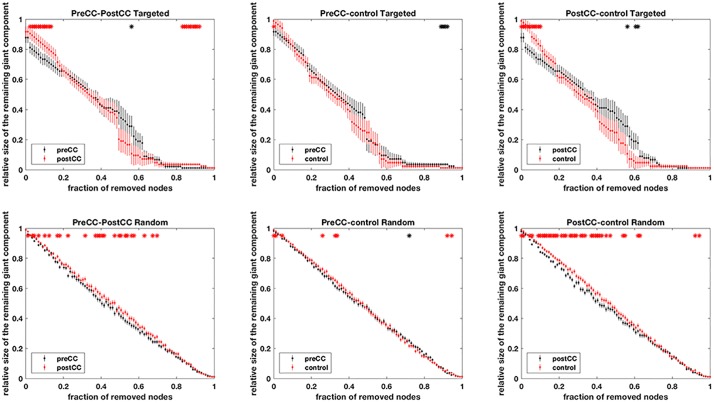
Results of assessments of network resilience to targeted attack or random failure among the three groups.The p-values of AUC comparisons between pre-CC and post-CC networks, between control and pre-CC networks, and between control and post-CC networks are shown in each targeted attack or random failure analysis. The trajectories of the relative size of the largest components as the principal nodes are demonstrated and each error bar represents the standard distribution for repetitive permutations. The asterisks denote significant differences between groups (p<0.05). The post-CC group showed significantly lower resilience to random failure than the pre-CC group and control group.